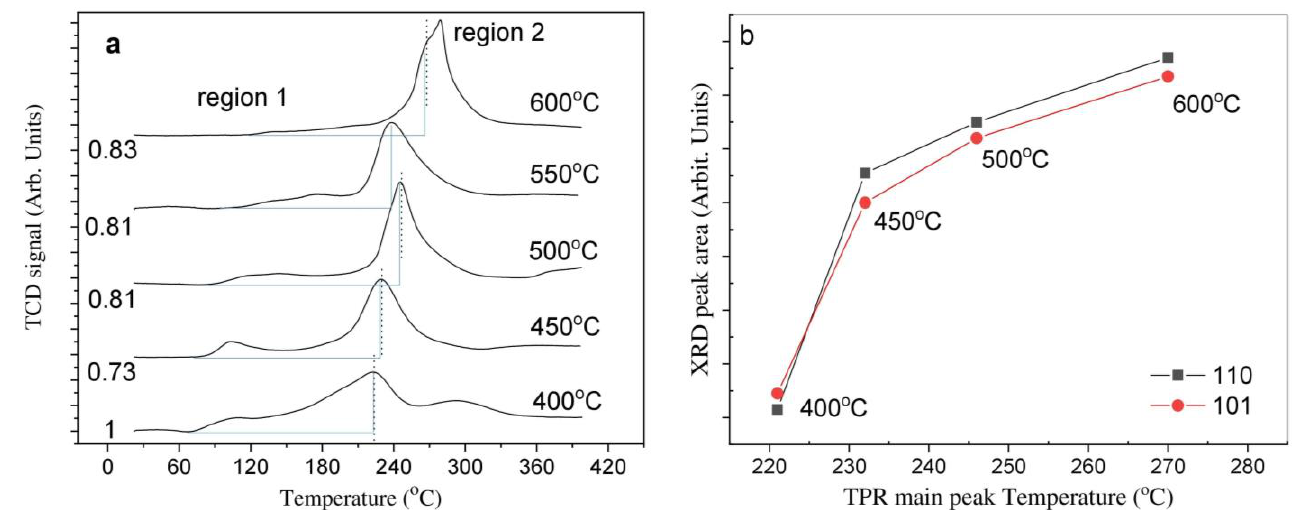
Figure 6. ( a ) TPR of 4 wt.% IrO 2 /TiO 2 calcined at the indicated temperatures. The numbers on the left-hand side are the relative peak areas obtained from the TCD signal. ( b ) A plot of the XRD peak areas of the (110) and (101) lines of IrO 2 as a function of the TPR peak temperature at the different calcination temperatures (the dashed lines in ( a )). TPR was conducted at a ramping rate of 10 °C/min and a flow rate of 50 mL min −1 (10% H 2 in Argon).